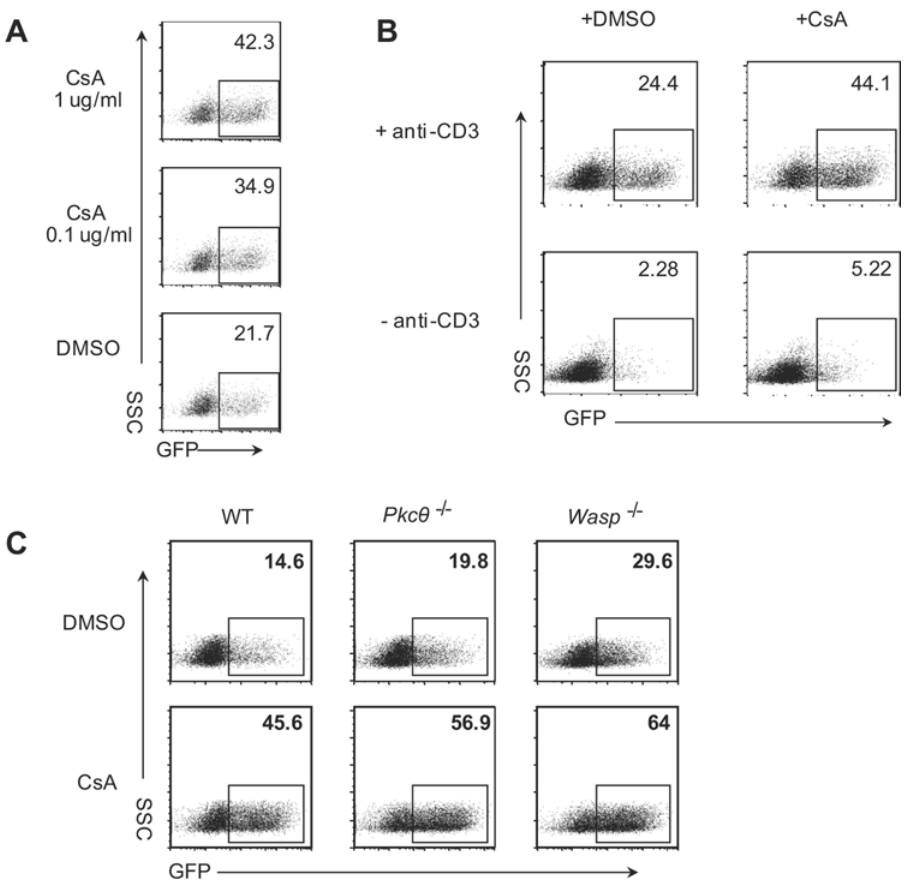
Figure 6. CsA further sensitizes the TCR effect on the pre-integration block in mouse T cells. (A) CD4 + T cells from hCyclin T1 transgenic mice were activated and infected with HIV-GFP (VSVG). Three hours post infection, cells were transferred to wells coated with anti-CD3 together with 0.1 m g/ml CsA, 1 m g/ml CsA or DMSO control. Twenty-four hours post infection, cells were washed twice with PBS and transferred to new wells with IL-2 alone. FACS analysis for GFP was done 48 h post infection. (B) Analysis was as in panel A except that at 3 h post infection cells were transferred to wells coated with or without anti-CD3, together with 0.1 m g/ml CsA. (C) CD4 + T cells from wild type, Pkc h 2 / 2 and Wasp 2 / 2 mice were activated and infected with HIV-CMV-GFP (VSVG). Three hours post infection, cells were transferred to wells coated with anti-CD3, together with 0.1 m g/ml CsA, Cells were then analyzed as in panel A.